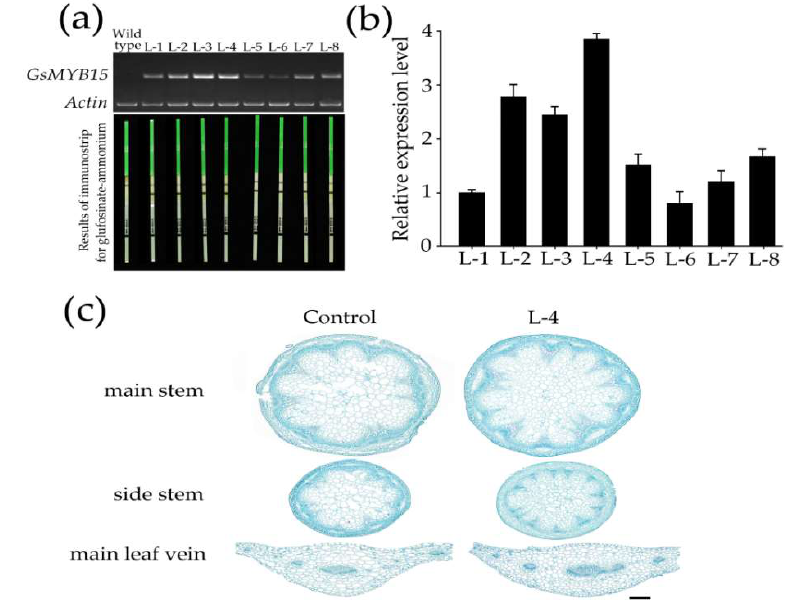
Figure 4. Analyses of GsMYB15 transgenic plants grown in soil. ( a ) Prove GsMYB15 transgenic Arabidopsis generations using semi-quantitative RT-PCR and immunostrip methods. ( b ) Expression levels of GsMYB15 in different transgenic Arabidopsis lines. GsSKIP16 was used as the internal reference control. Each point represents the mean value of three independent experiments performed in triplicate ± SE. ( c ) Four-week-old rosette leaves, main stems and side stems from the top were chosen for transverse section analysis. Bar = 200 μm.